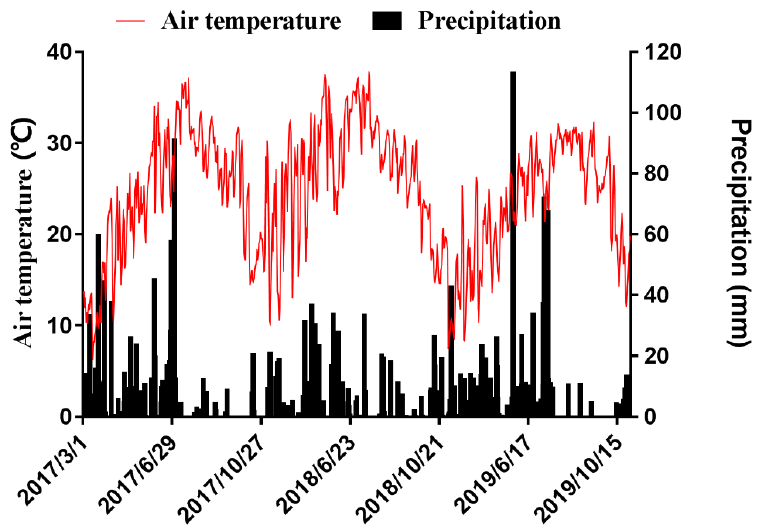
Figure 1. Daily temperature and precipitation of the entire rice growing season in Santang from March to November.